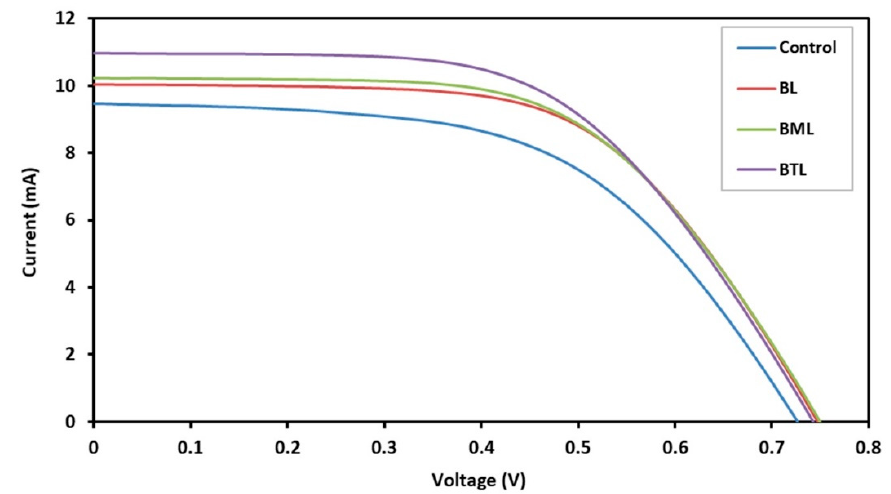
Figure 12. I–V curve of the fabricated DSSC integrated with and without nanocrystalline TiO 2 layer. Table 2. Photovoltaic parameters of the DSSC integrated without (control sample) and with nanocrystalline TiO 2 layer. FF—fill factor.